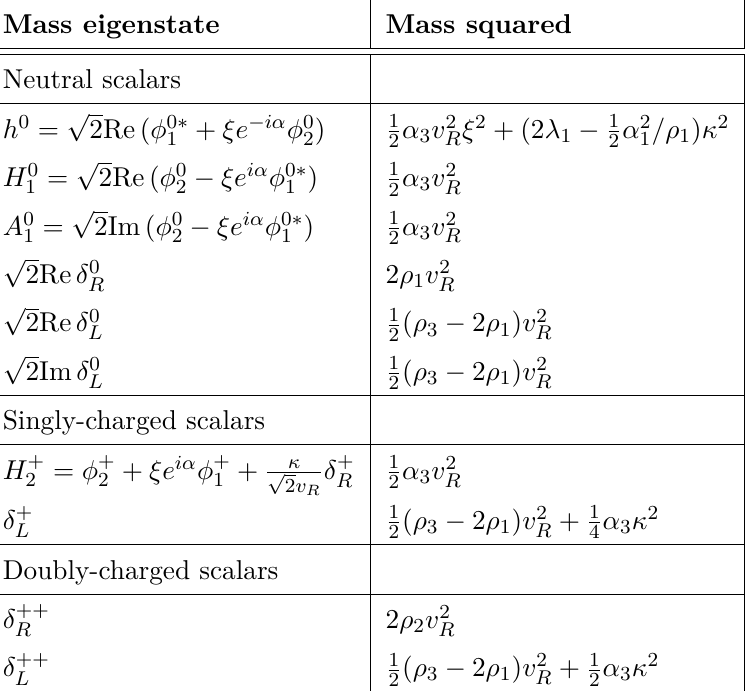
and ξ ≡ κ 0 /κ have been kept [38, 182, R